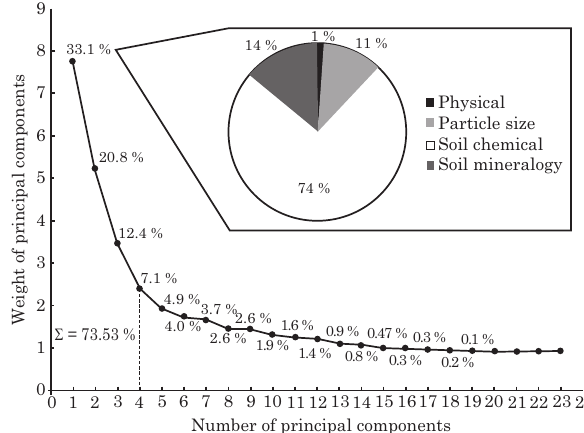
Figure 2. Variance in the body of properties explained by each principal component and contribution of soil chemistry, particle size distribution, soil physical and soil mineralogical properties to